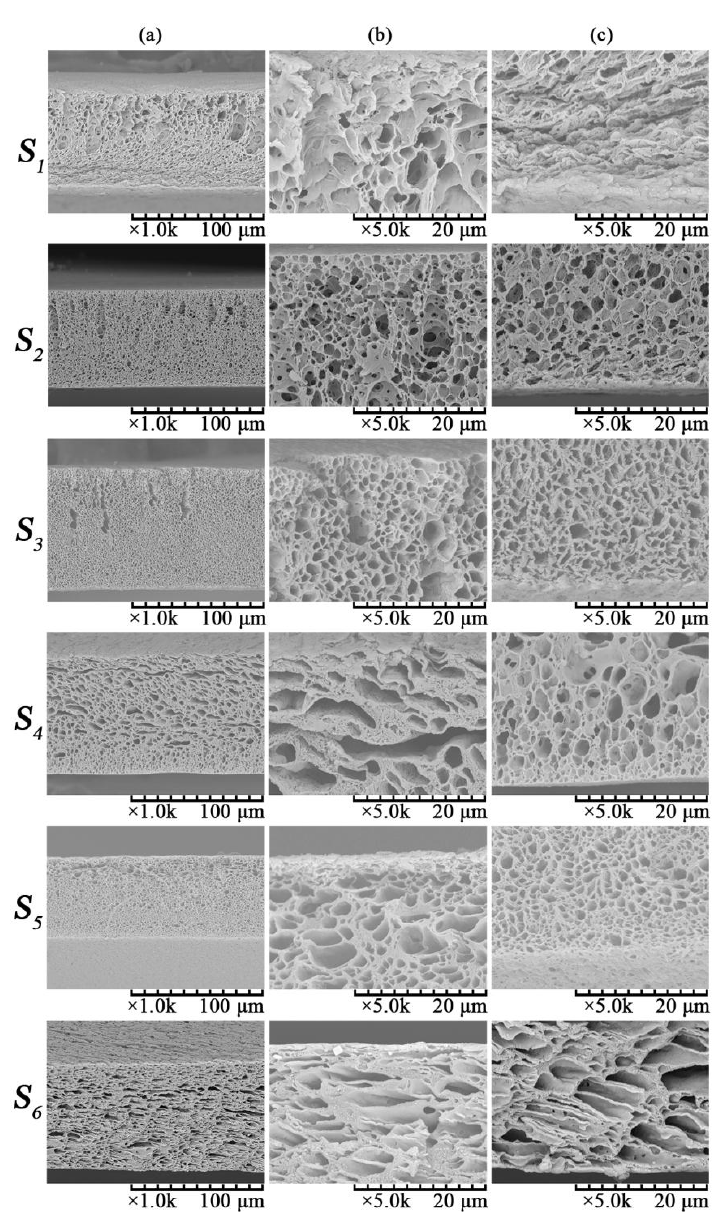
Figure 1. SEM images of PVDF/PVA membranes S 1 – S 6 : ( a ) full cross-section; ( b ) cross-section adjacent to the top surface; ( c ) cross-section adjacent to the bottom surface.